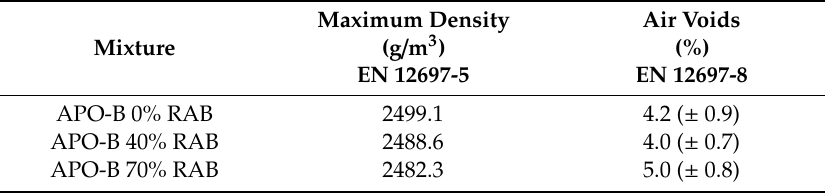
Table 2. Volumetric properties of the asphalt